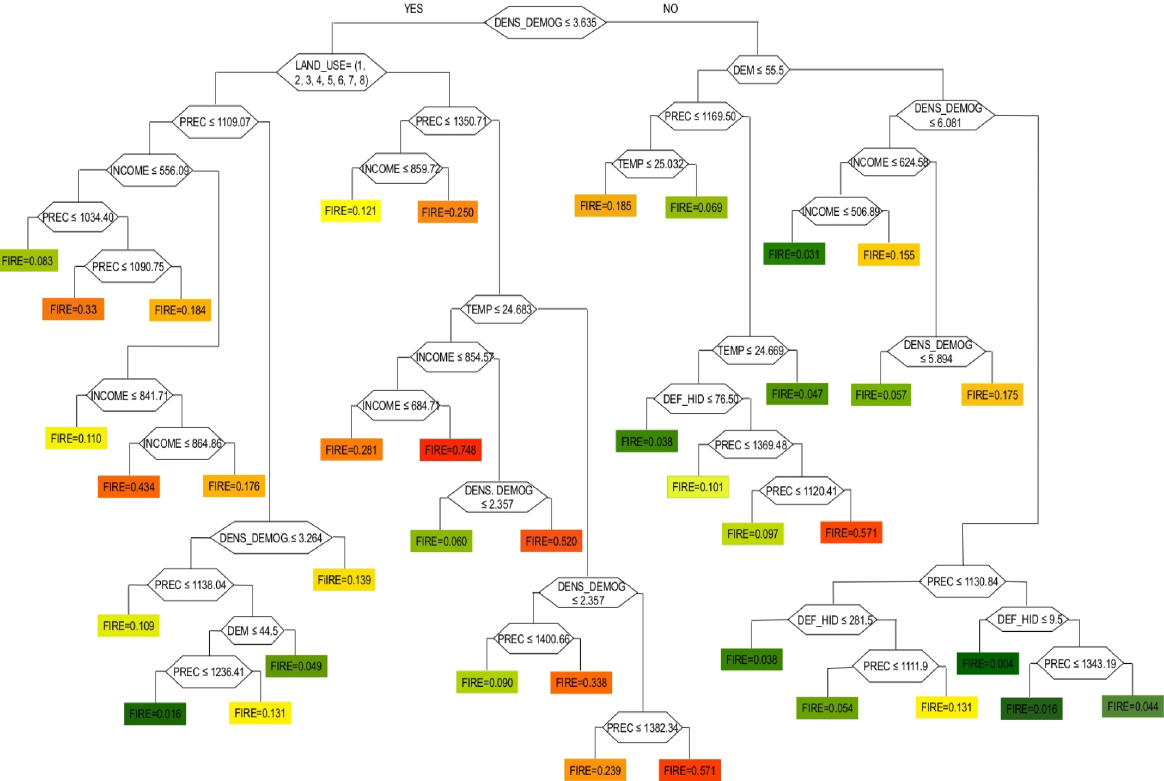
Figure 4. Regression rules described in binary tree form. Predicting variables codes and their classes or ranges are listed in Table